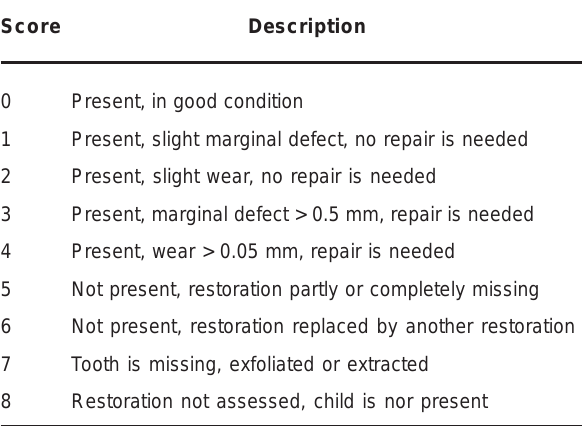
TABLE 1- Codes used in the evaluation of the ART restorations